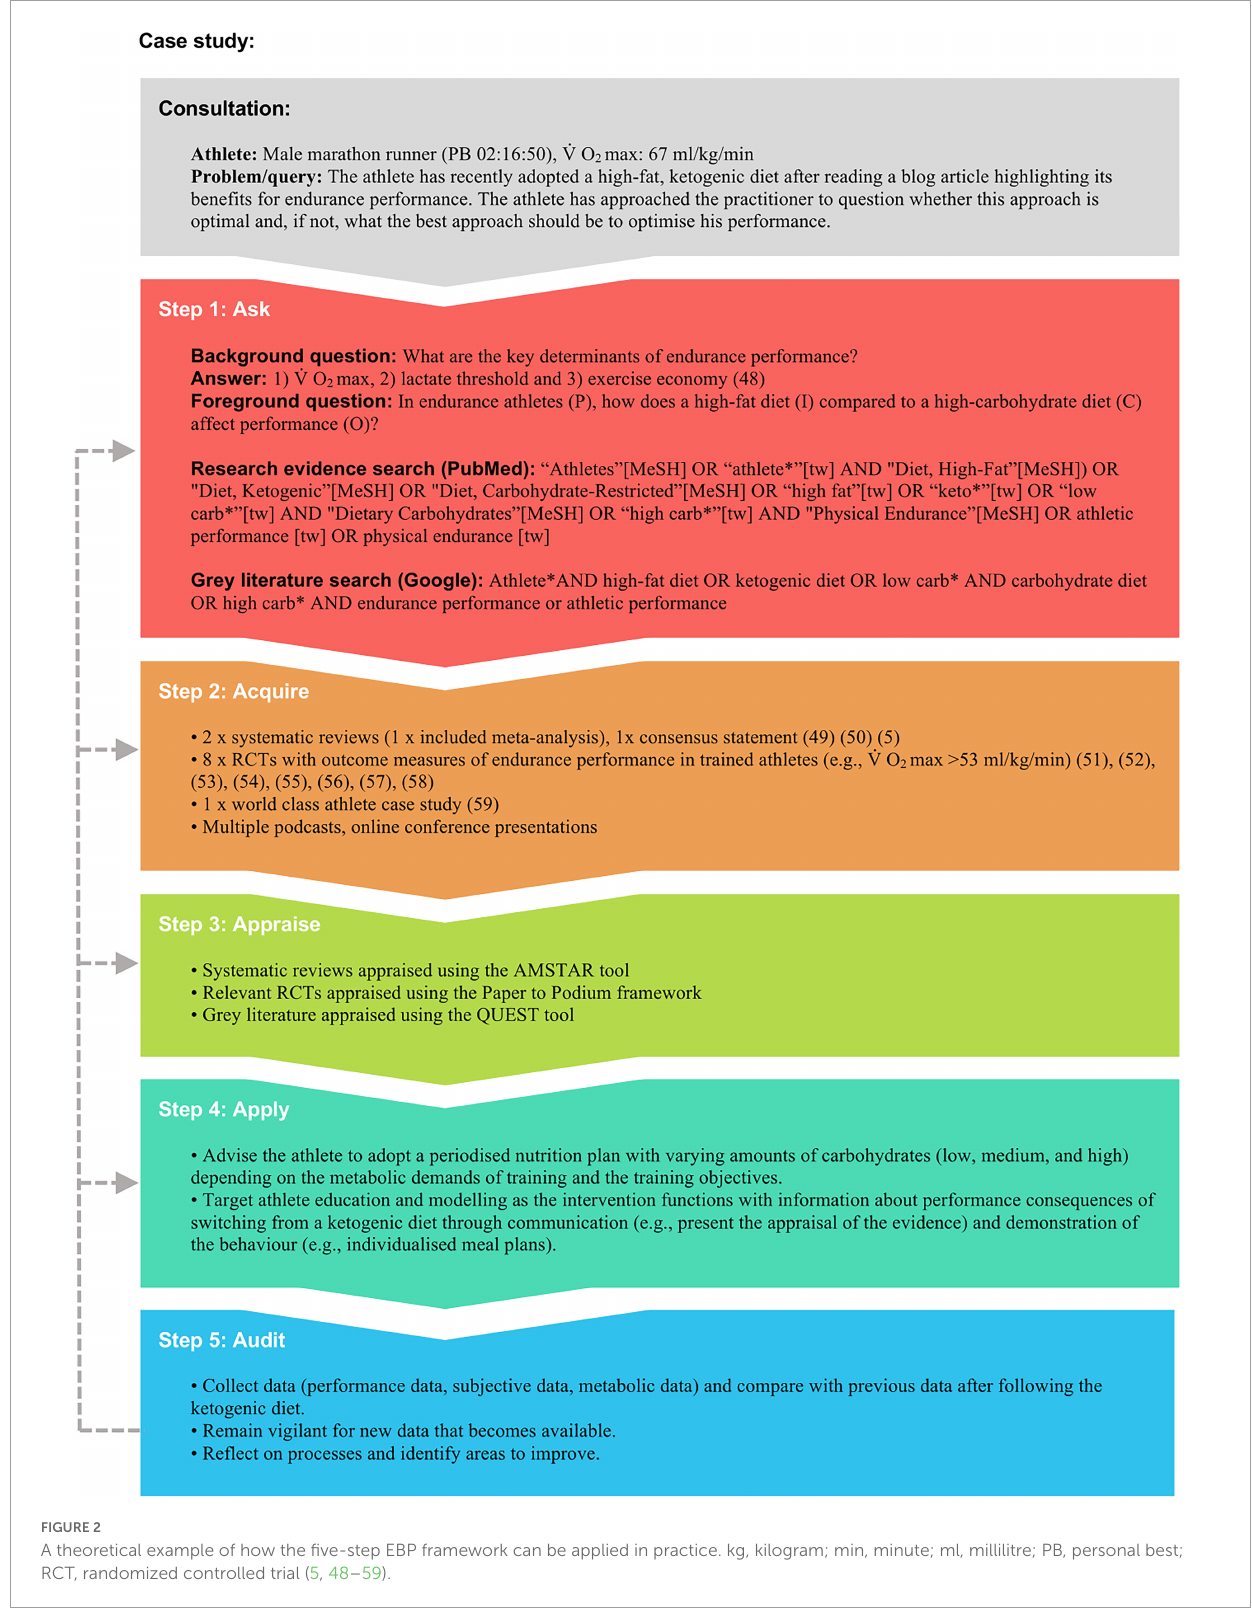
on the COM-B paradigm and provides a series of intervention functions and policies to assist with the effective implementation of behaviour